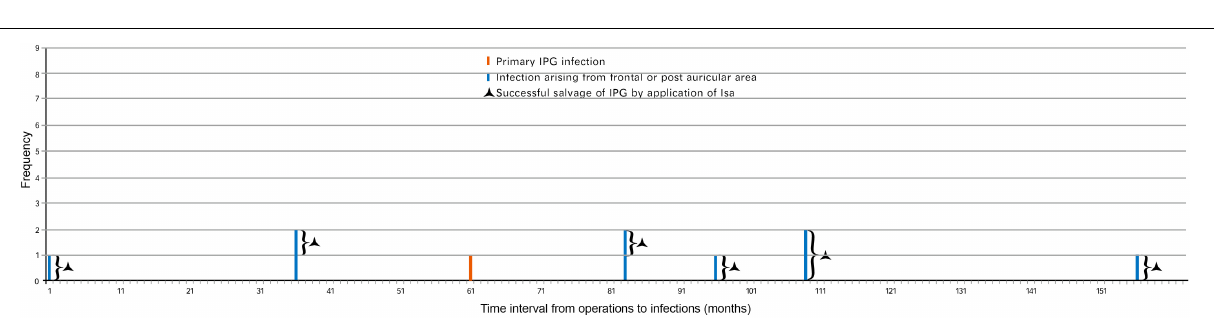
FIGURE 5 | Hardware-related infections in group B (time interval to diagnosis of infection). Ten cases of hardware-related infections were enrolled in group B (between July 2014 and May 2019) based on the date of diagnosis. One case presented early-onset infection while nine cases presented late-onset infection. IPG, implantable pulse